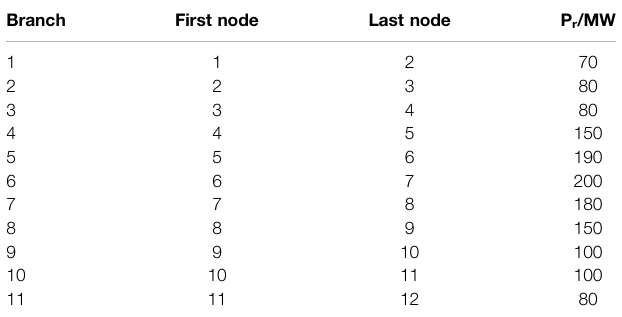
TABLE 1 | 11 generator 14 node system branch parameters.